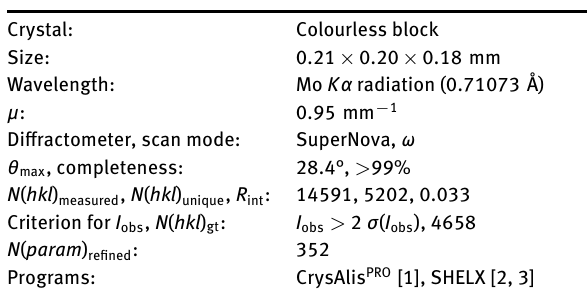
Table 1: Data collection and handling.